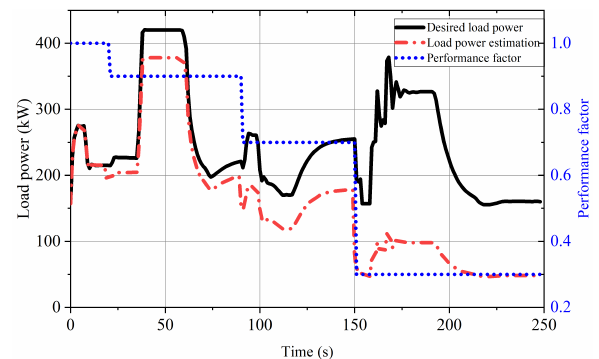
Figure 7. Waterjet load power estimation result.